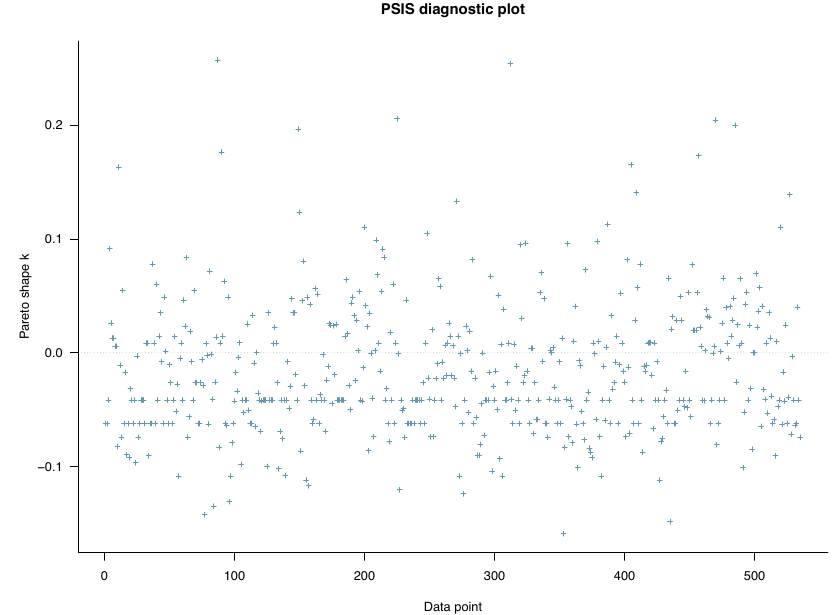
Fig. 2 Model 1 ’ s PSIS-LOO diagnosis with priors as norm (1,0.5). The model ’ s goodness-of- fi t can be classi fi ed into four levels: (1) ‘ good ’ if its k -values are all below 0.5, (2) ‘ OK ’ if its k -values are more than 0.5 and below 0.7, (3) ‘ bad ’ if its k -values are more than 0.7 and below 1, and (4) ‘ very bad ’ if its k - values are more than